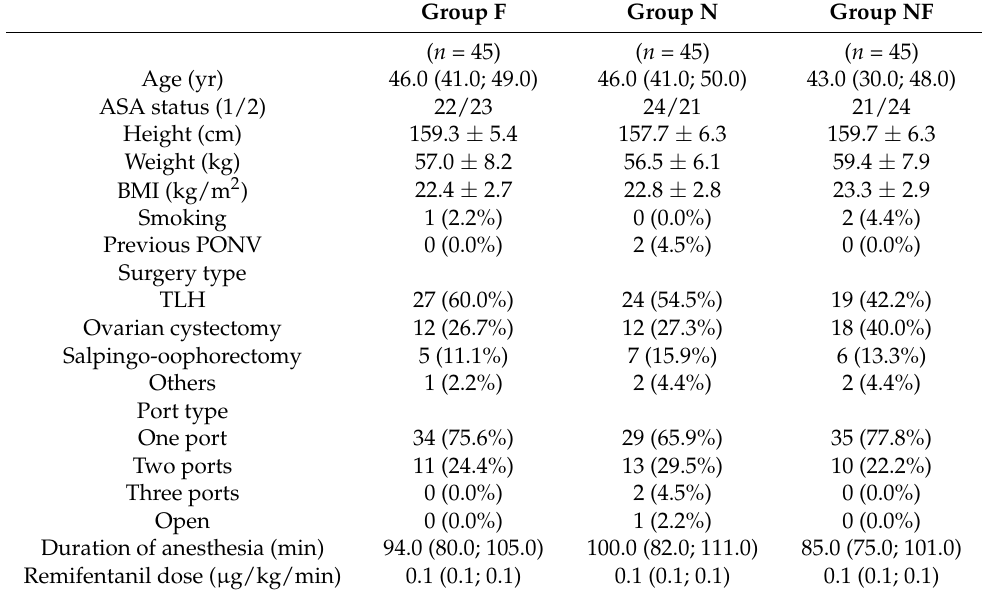
Table 1. Demographic and clinical characteristics.